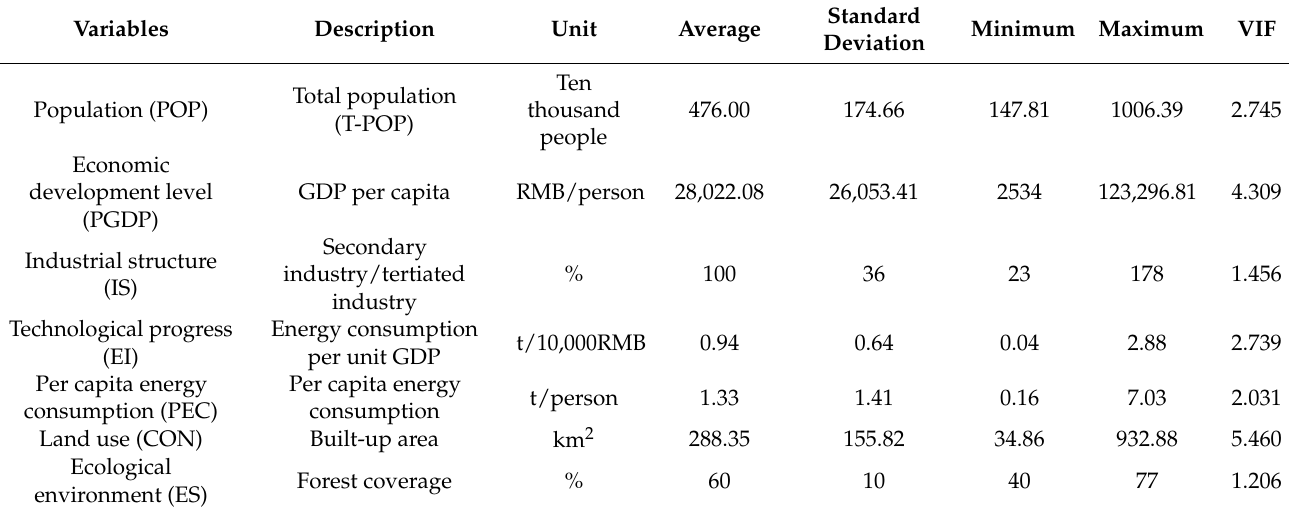
Table 5. Definition and statistical description of related variables.